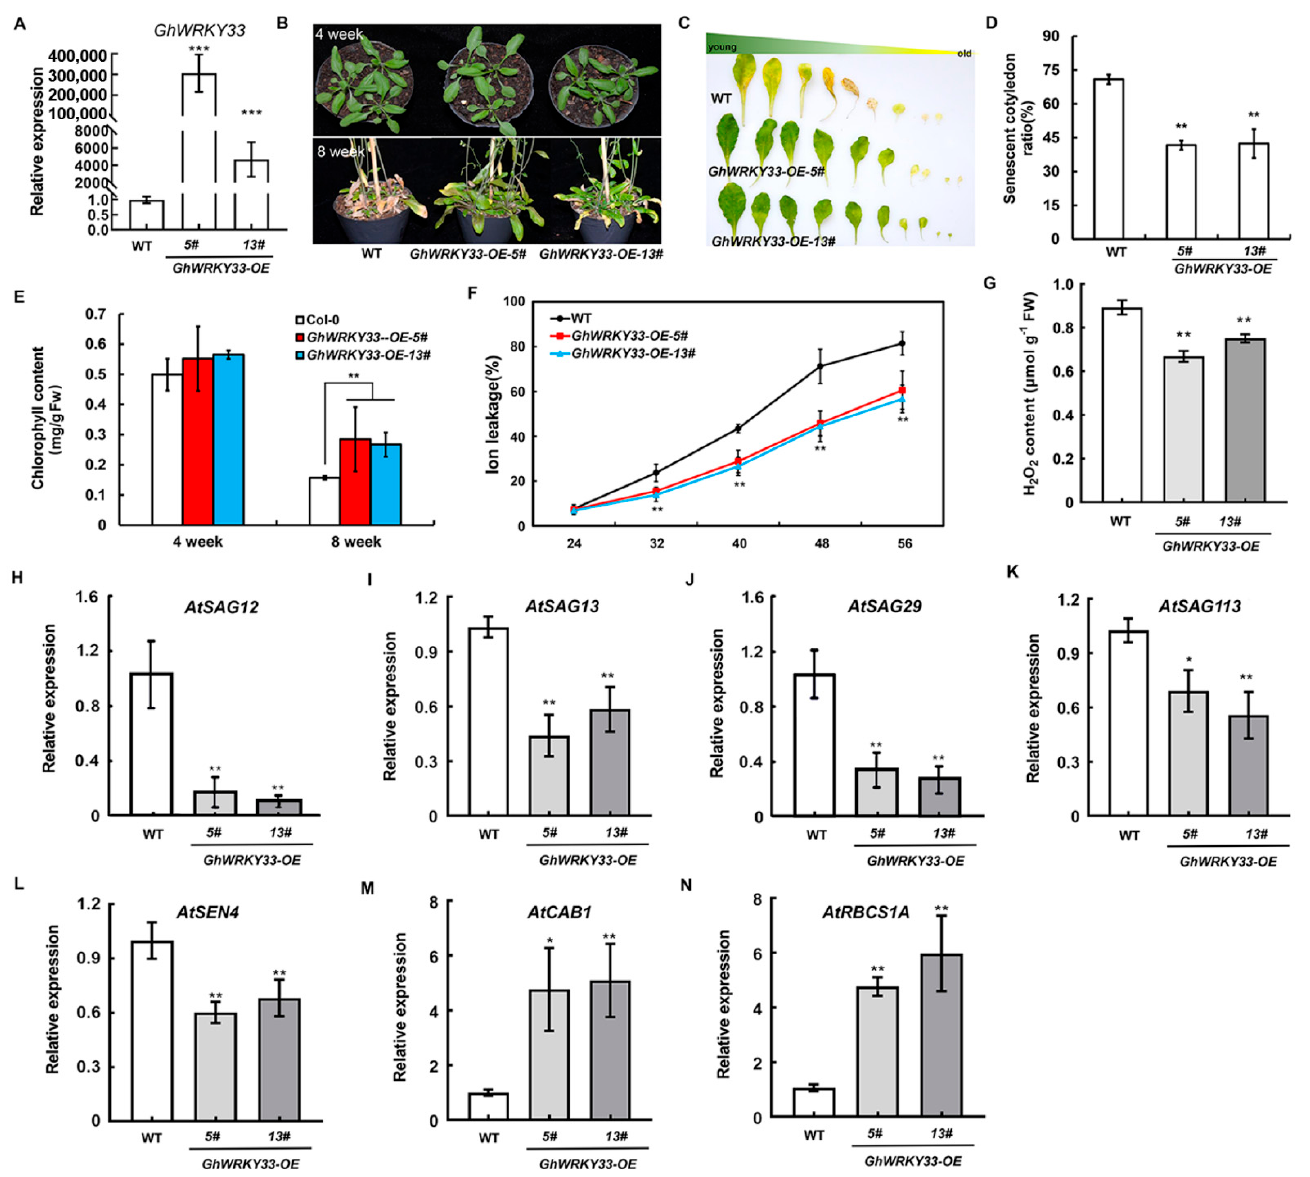
Figure 1. Overexpression of GhWRKY33 in Arabidopsis delayed leaf senescence. ( A ) Transcript levels of GhWRKY33 in transgenic plants. ( B ) Phenotypic characteristics of WT and transgenic plants grown for four and eight weeks, respectively. Plants were grown in a growth chamber at 22 °C under a 16 h light/8 h dark photoperiod, and the natural senescence phenotype was observed from about 72 plants for each line, and representative plants were photographed. ( C ) Senescence symptoms of detached leaves of eight-week-old WT and transgenic plants sorted based on their age. ( D ) Relative senescent cotyledon ratio of WT and GhWRKY33-OE plants grown for four weeks.( E ) Chlo- rophyll content in detached rosette leaves of WT and GhWRKY33-OE plants grown for four and eight weeks, respectively. FW, fresh weight. ( F ) Membrane ion leakage of WT and GhWRKY33 -OE plants at the indicated leaf age. Leaves three to four from 12 to 15 plants of each genotype (approx- imately 26 leaves) were harvested and pooled. ( G ) H 2 O 2 content in rosette leaves of WT and GhWRKY33-OE plants grown for eight weeks. ( H – N ) Transcript levels of AtSAGs, AtCAB1, and AtRBCS1A in the indicated genotypes. Data from three biological replicates were analyzed by ANOVA, and asterisks show significant differences compared with WT (* p < 0.05; ** p < 0.01; *** p < 0.001).